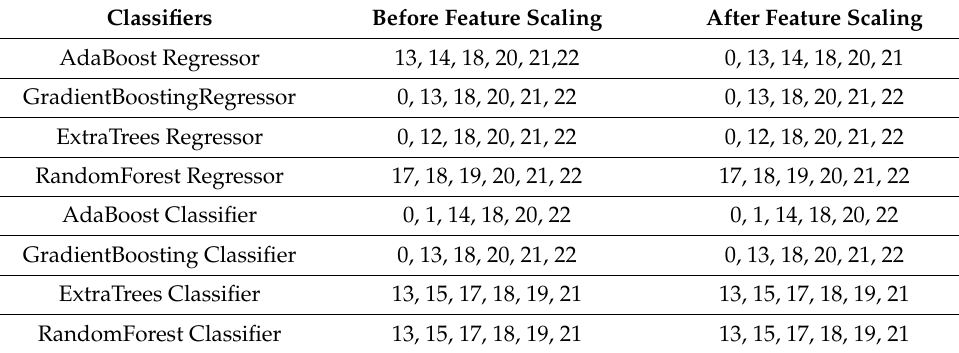
Table 8. Feature importance index of regressor and classifier methods.